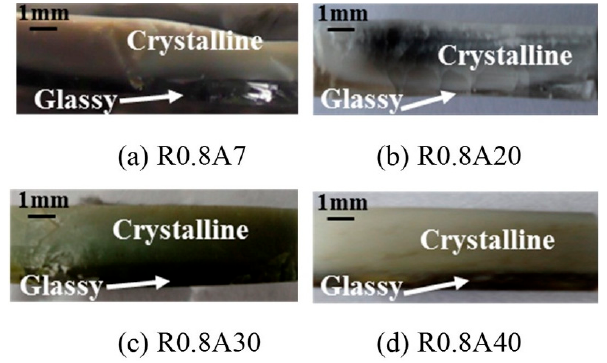
Figure 11. The snapshots of cross ‐ section of the mold flux disks after the heat transfer test.